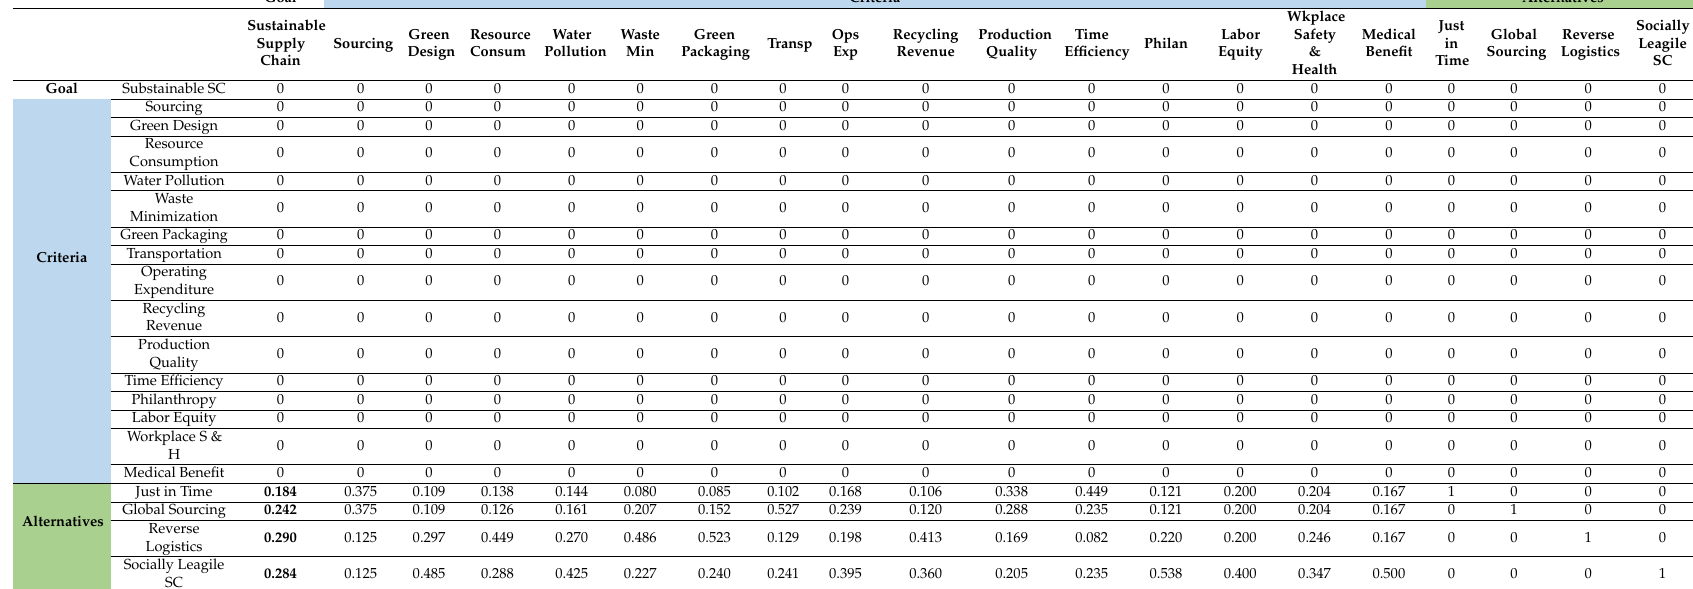
Table 10. Limit matrix for the equivalent AHP